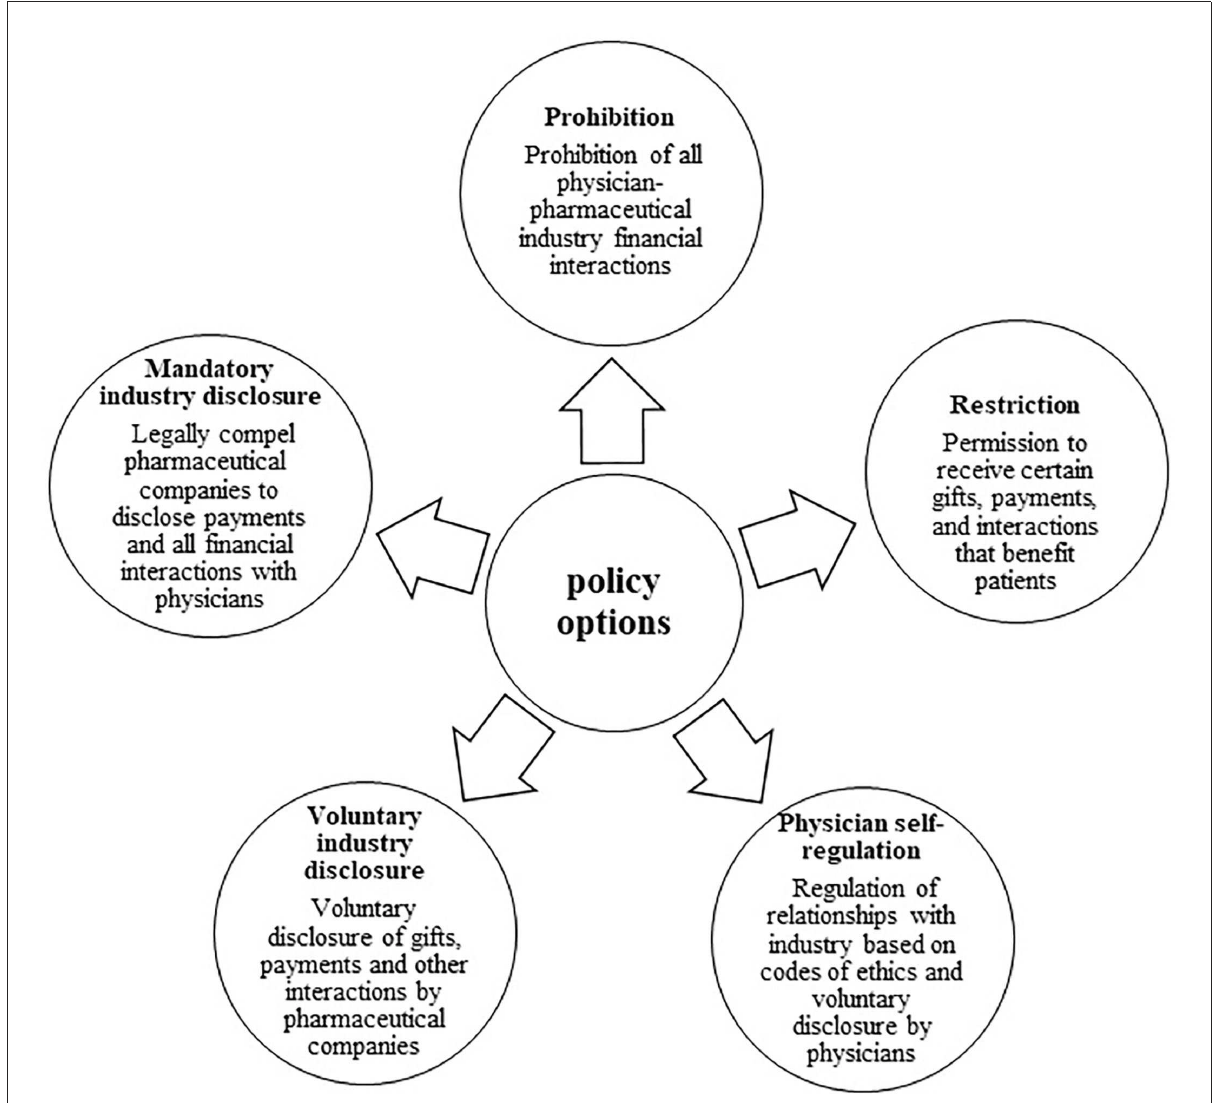
FIGURE2 Policy options for managing the COI arising from the physician-industry